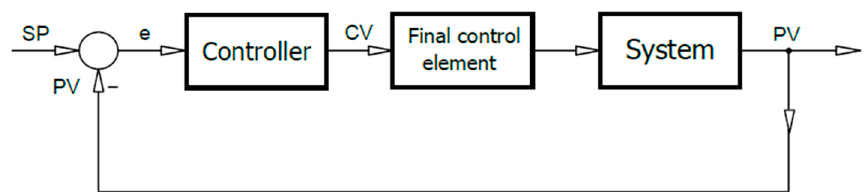
Figure 1. Simplified block diagram of the structure of the closed loop automatic control system. Notion: SP—setpoint; PV—process variable; e—control error; and CV—control value.